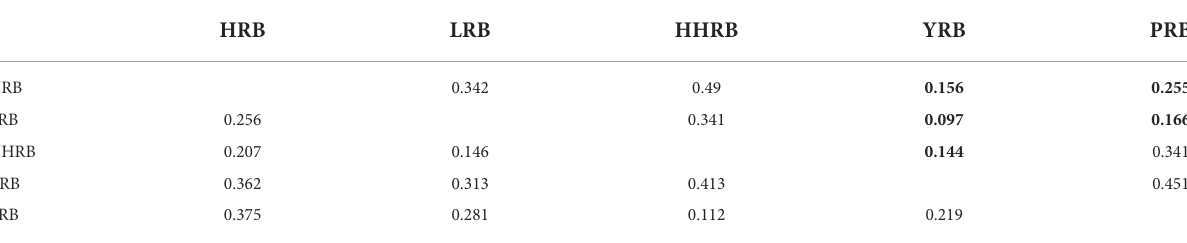
TABLE 8 Niche identity tests between genetic group pairs. HRB